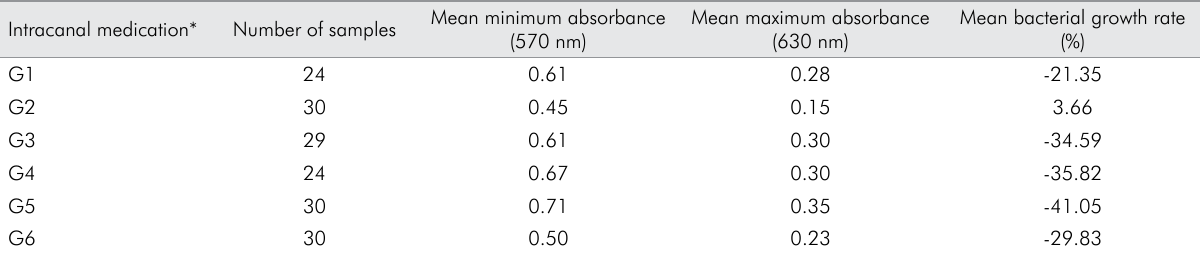
Table 1. Descriptive analysis of the bacterial growth rate based on the variable intracanal